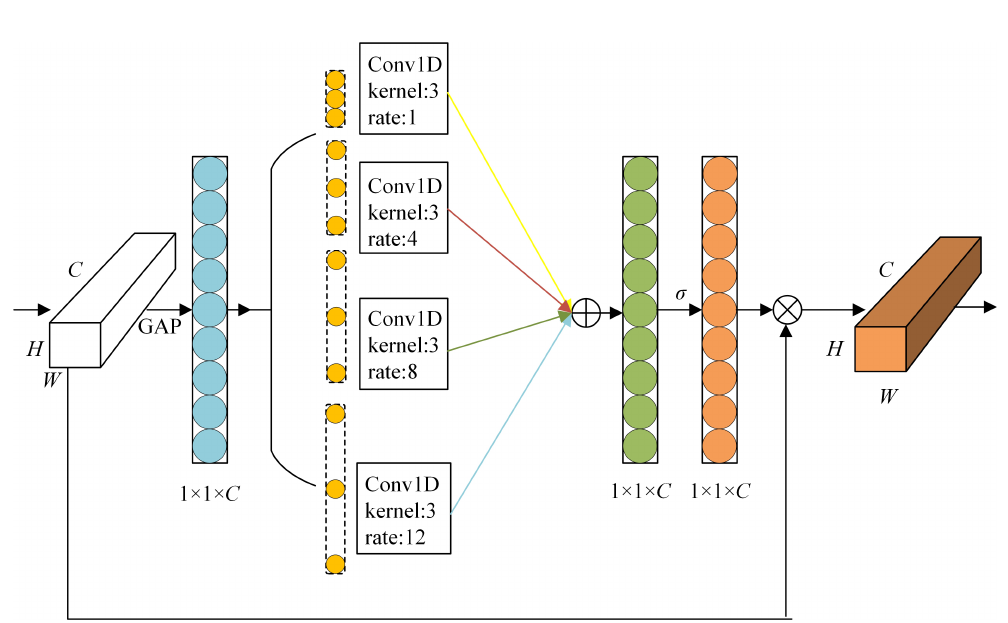
Figure 2. Architecture of the ACPA